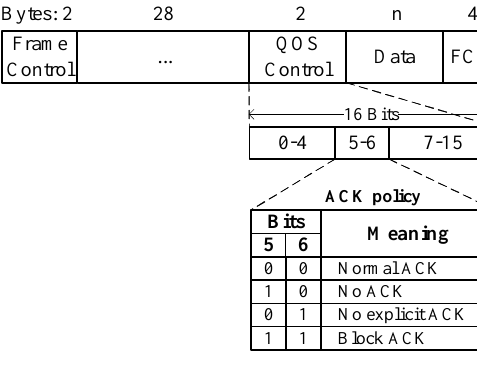
Figure 3. Frame format in IEEE